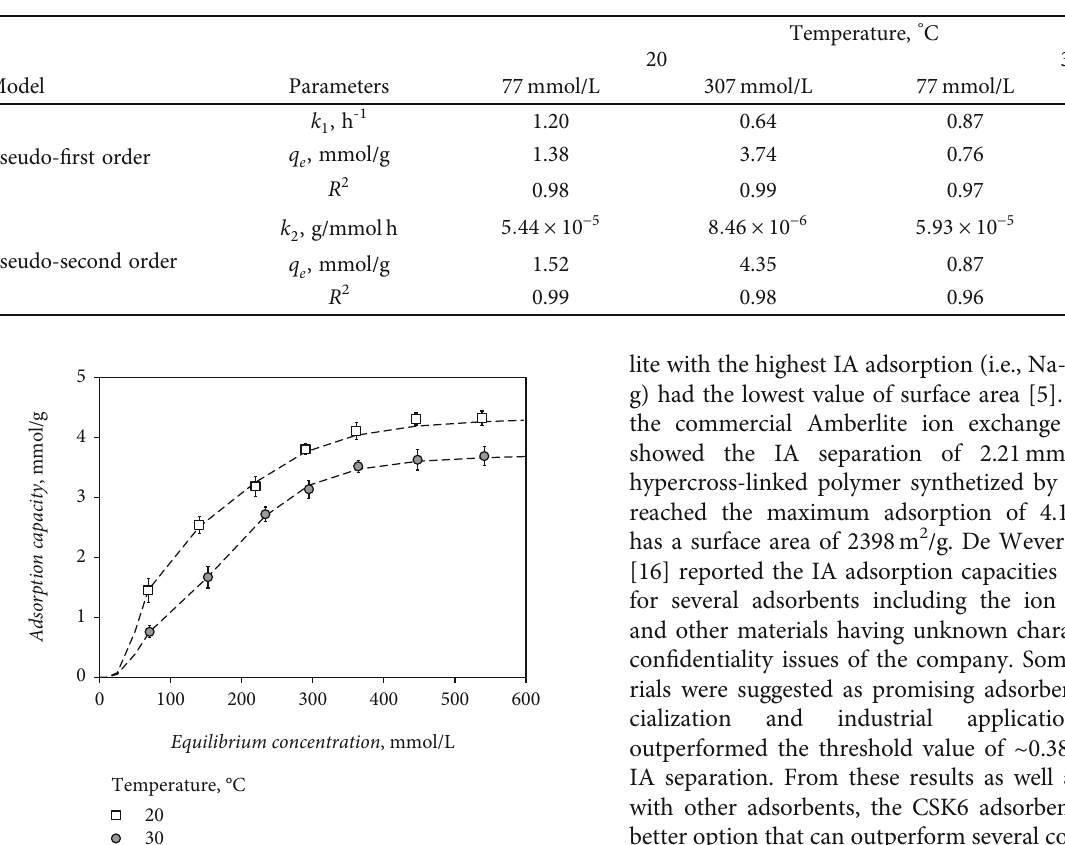
Figure 6: Adsorption kinetics for the separation of itaconic acid from the aqueous solution at pH 3 and modeling with the pseudo- fi rst- order (PPO) and pseudo-second-order (PSO) equations. ○ means experimental adsorption data. Table 2: Kinetic parameters for the separation of itaconic acid from the aqueous solution at pH3 using CSK6 adsorbent.